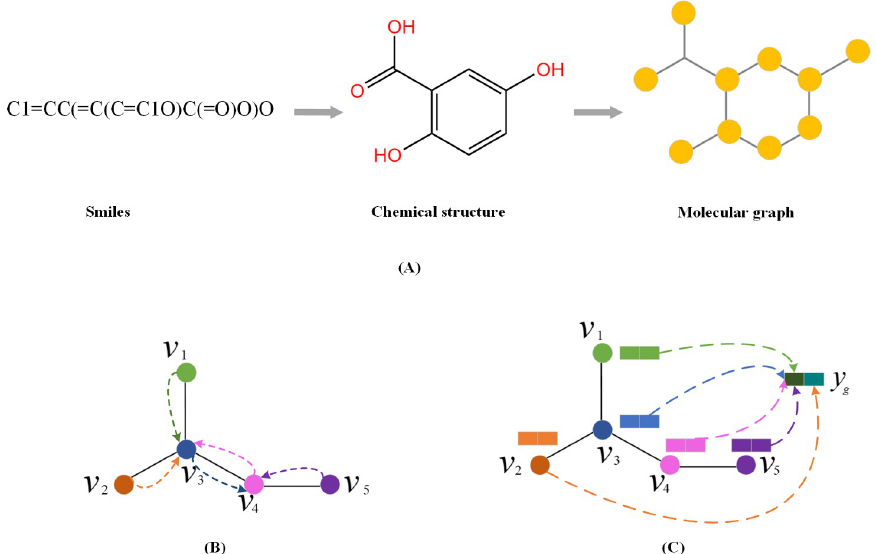
Fig 13. Molecule representation and graph embedding. (A) Preprocessed the smiles into graph. (B) Graph message passing phase. (C) Graph readout phase.